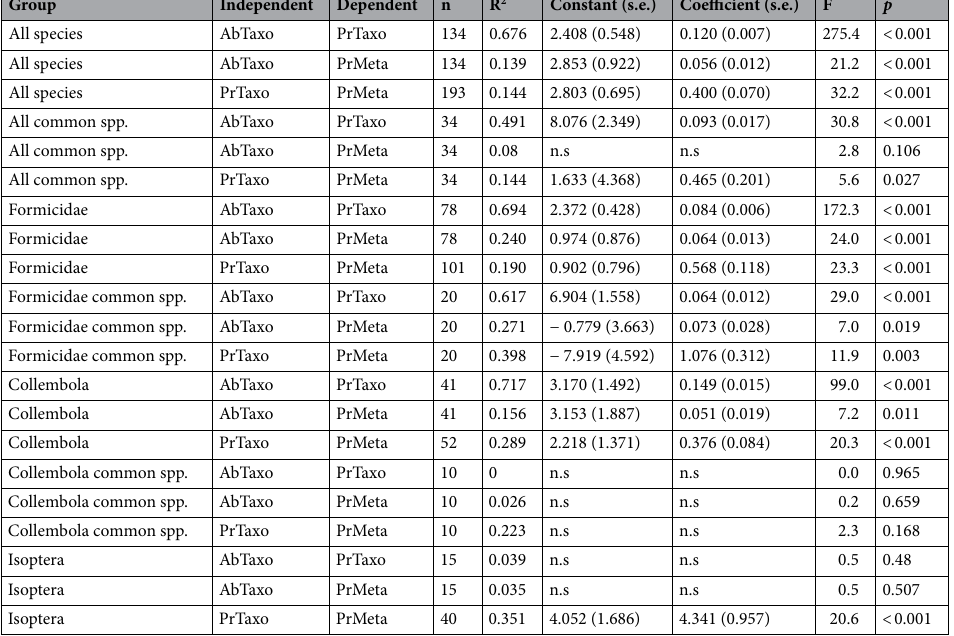
Table 2. Linear regressions including Formicidae, Collembola, Isoptera species and the following independent and dependent variables: AbTaxo abundance in traditional samples, PrTaxo prevalence in traditional samples, PrMeta prevalence in metabarcoding samples, PrTaxo prevalence in traditional samples. Regressions for common species of termites could not be tested because of small sample